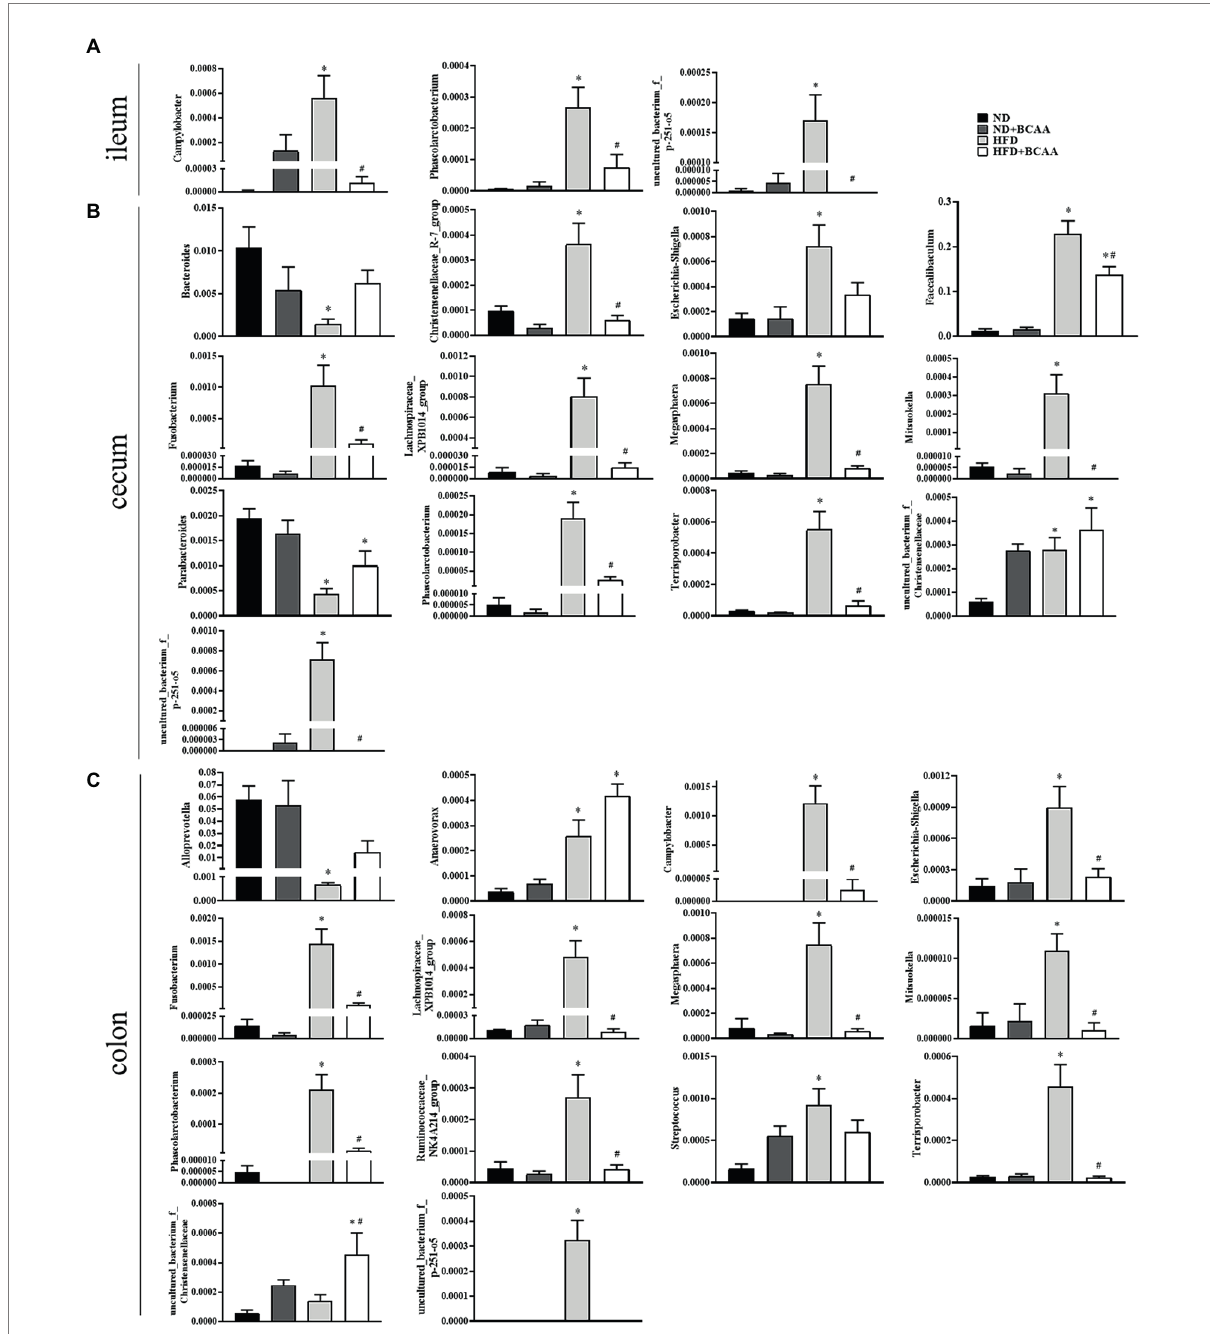
FIGURE 8 Effect of BCAAs supplementation on the relative abundances of gut bacteria. (A) Relative abu ndances of Campylobacter, Phascolarctobacterium, and uncultured_bacterium_f_p-251-o5 in the ileum . (B) Relative abundances of Bacteroides, Christensenellaceae_R-7_group, Escherichia- Shigella, Faecalibaculum, Fusobacterium, Lachnospiraceae_XPB1014_group, Megasphaera, Mitsuokella, Parabacteroides, Phascolarctobacterium, Terrisporobacter, uncultured_bacterium_f_Christensenellaceae, and uncultured_bacterium_f_p-251-o5 in the cecum . (C) Relative abundances of Alloprevotella, Anaerovorax, Campylobacter, Escherichia-Shigella, Fusobacterium, Lachnospiraceae_XPB1014_group, Megasphaera, Mitsuokella, Phascolarctobacterium, Ruminococcaceae_NK4A214_group, Streptococcus, Terrisporobacter, uncultured_bacterium_f_Christensenellaceae,